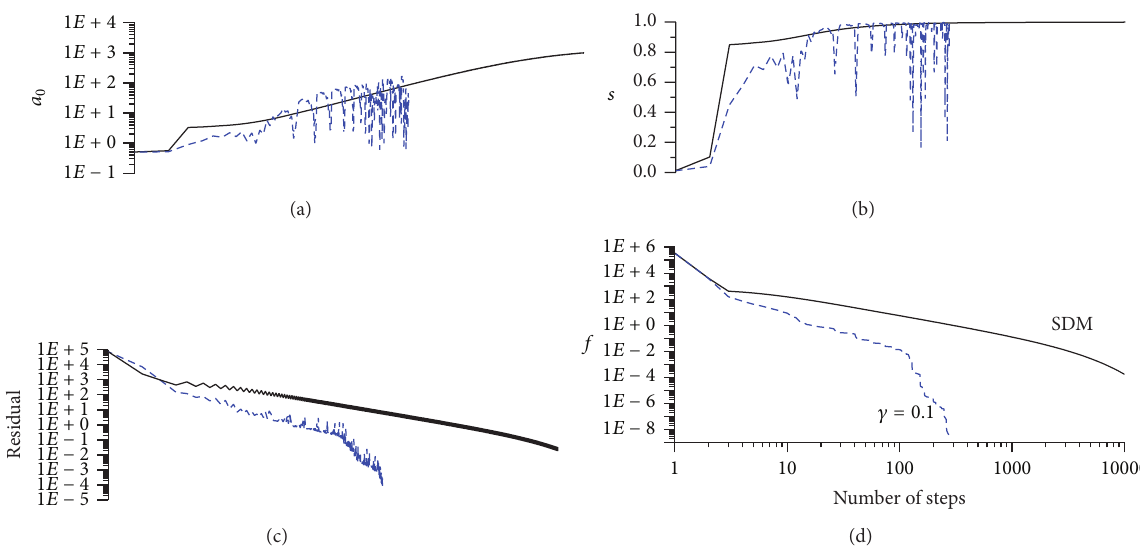
Figure 10: For the minimization of Schwefel function comparing (a) 𝑎 0 , (b) 𝑠 ,(c) residual error, and (d) 𝑓 obtained by the SDM and OA. the half-interval method, with two end points fixed by 𝜆 = 0 and 𝜆 = 1 , and the convergence criterion is given by 𝜀 = 10 −10 . At the end of the iteration we obtain the minimum −12 , which is very value of 𝑓 to be 𝑓 = 9.79 × 10